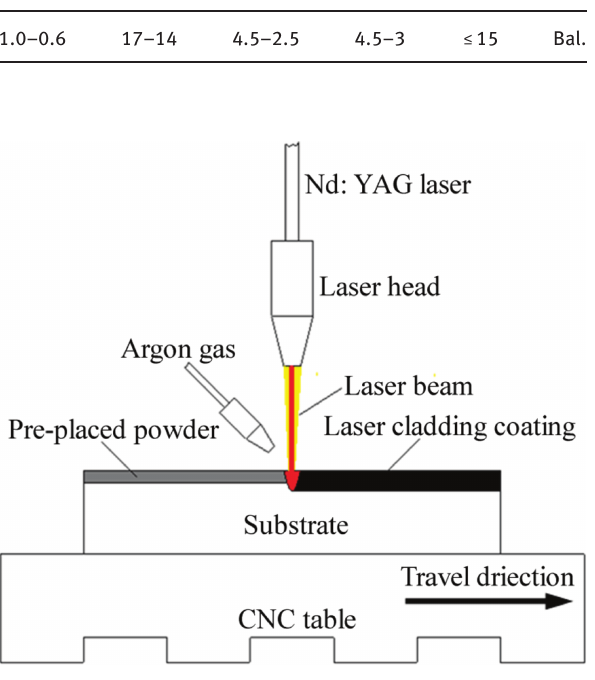
Figure 1: Schematic of laser cladding